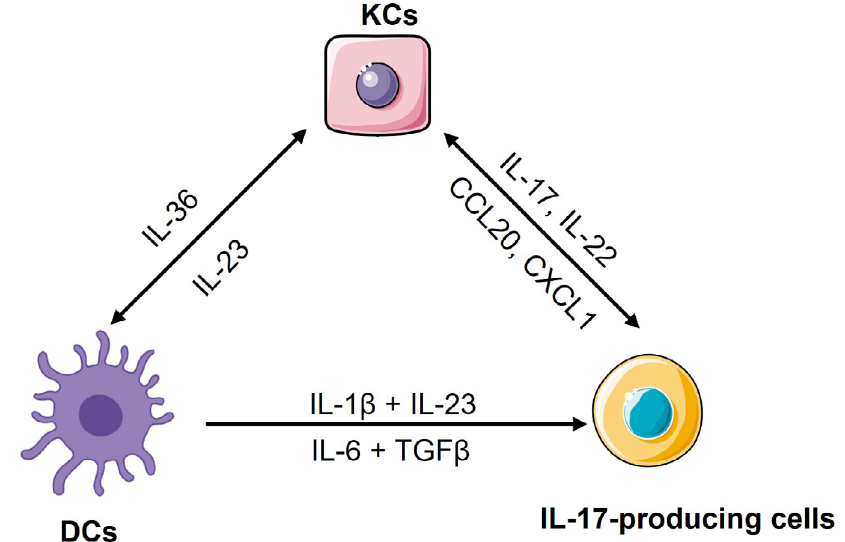
Figure 1. The crosstalk among keratinocytes, DCs and IL-17-producing cells. Upon skin injury, keratinocytes produce IL-36 to activate mDCs for releasing IL-1β, IL-6 and IL-23. In mice, IL-6, together with TGFβ, induce naive CD4 + T cells differentiation into Th17 cells, while in human, IL-1β together with IL-23, induce naive CD4 + T cells differentiation into Th17 cells. These cytokines also induce and/or activate other IL-17-producing cells to produce IL-17, IL-22 and other Th17 cytokines. Among these Th17 cytokines, IL-17 and IL-22 induce keratinocytes to produce chemokines such as CCL20 and CXCL1 for recruiting neutrophils and more IL-17-producing T cells into sites of inflammation in the skin, or induce keratinocytes to produce more IL-36, thus forming a feed-forward inflammatory loop. KCs: